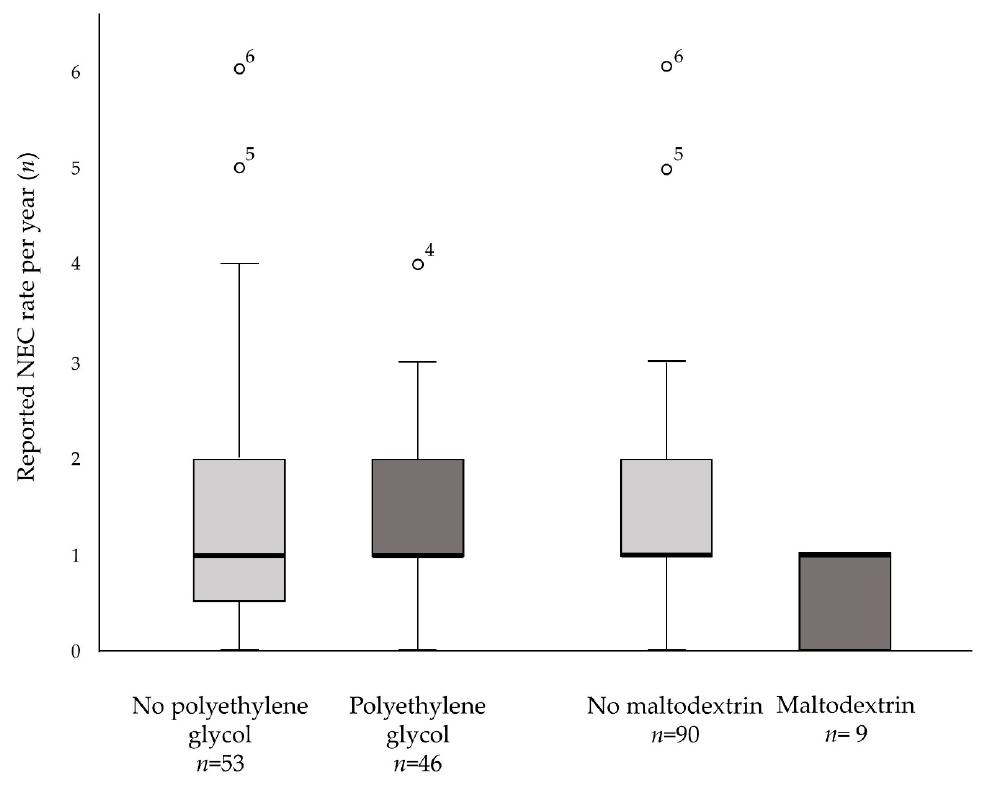
Figure 2. Boxplot distribution of reported NEC rate per year and interventions used (use vs. no use of polyethylene glycol and maltodextrin). Dots indicate outlier values. The NEC rate was provided by 99 participating units. NEC—necrotizing enterocolitis.